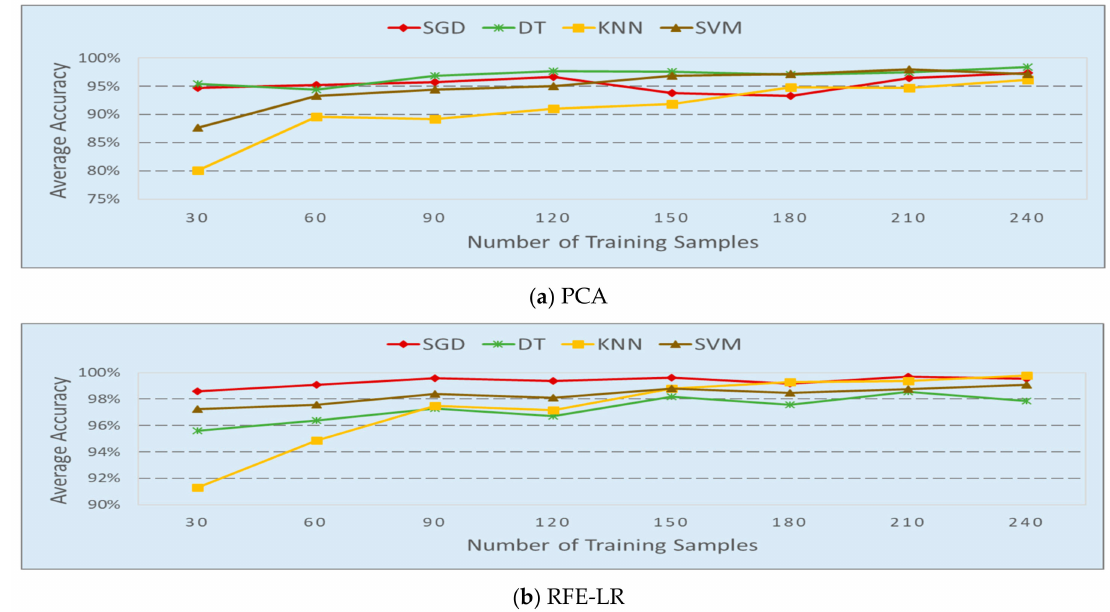
Figure 7. Average accuracy vs. number of samples used for classifier